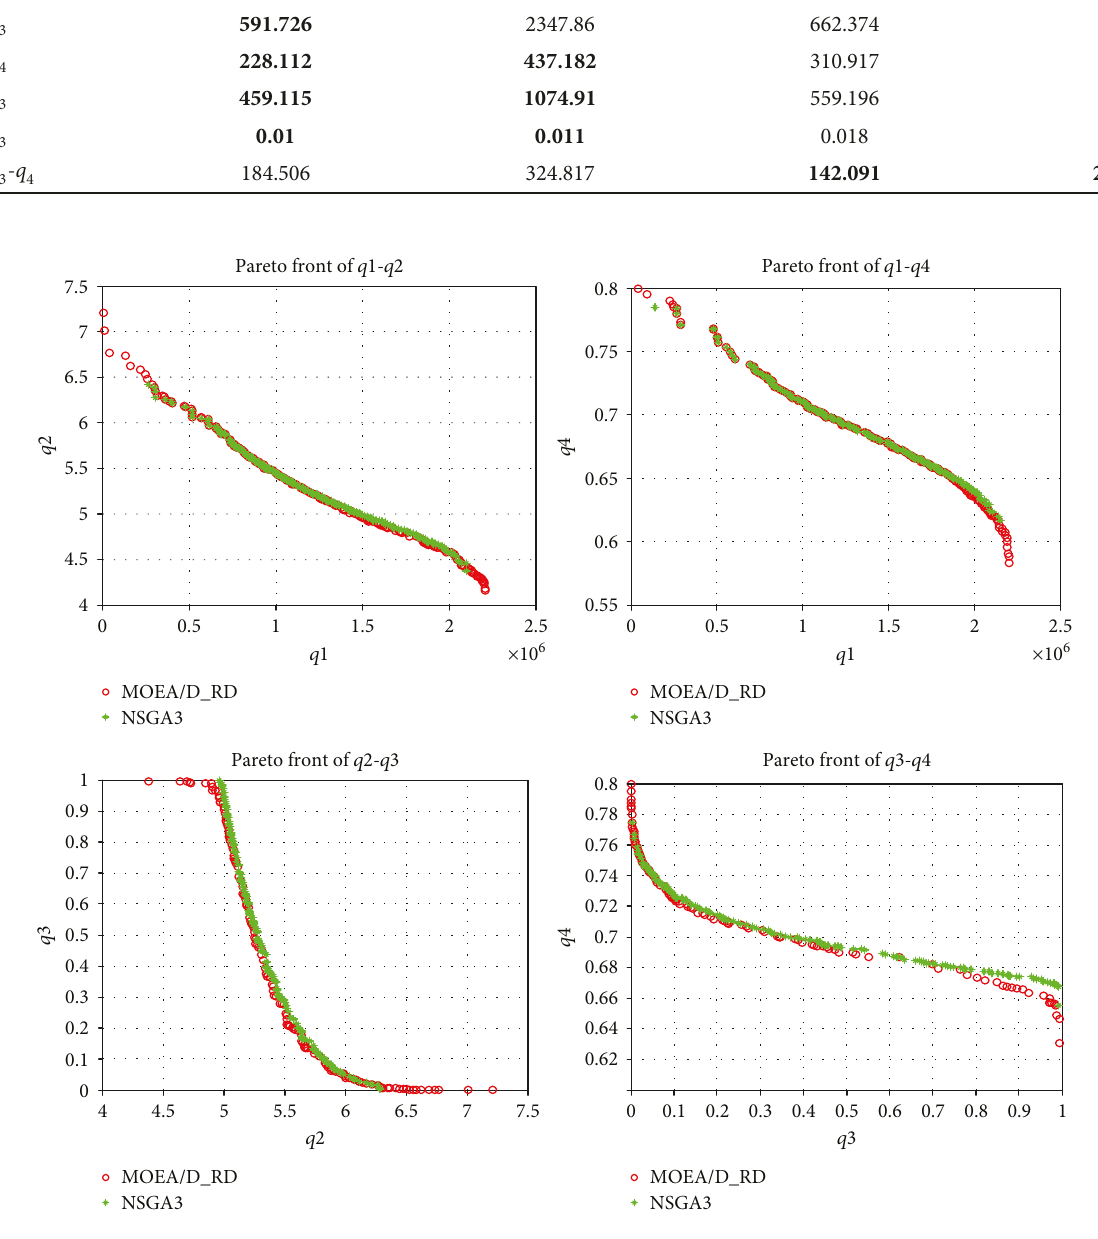
Figure 14: Comparison of PF between MOEA/D_RD (red circle) and NSGA3 (green ∗ ) for 2-objective